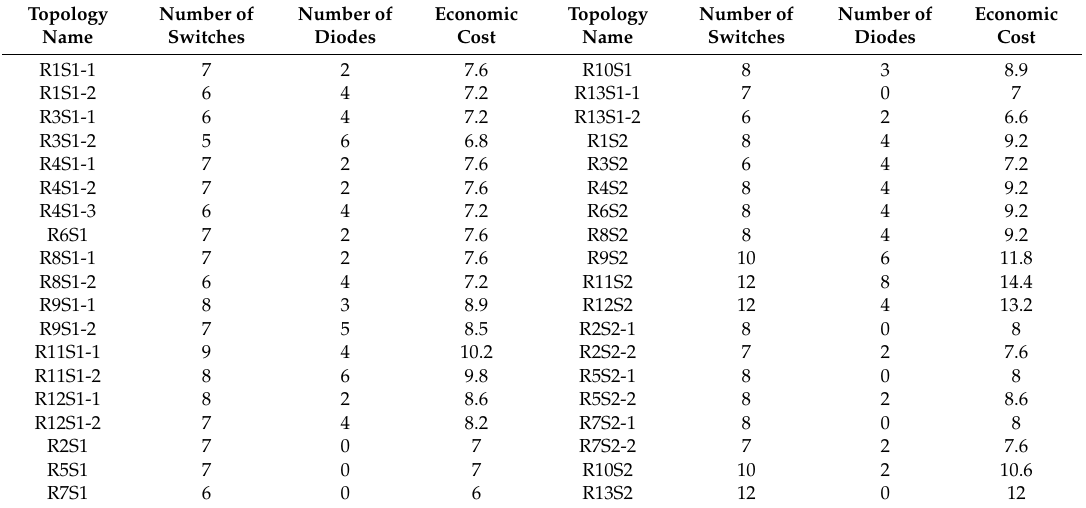
Table 5. Comparison of the Inverter topologies under USPWM.